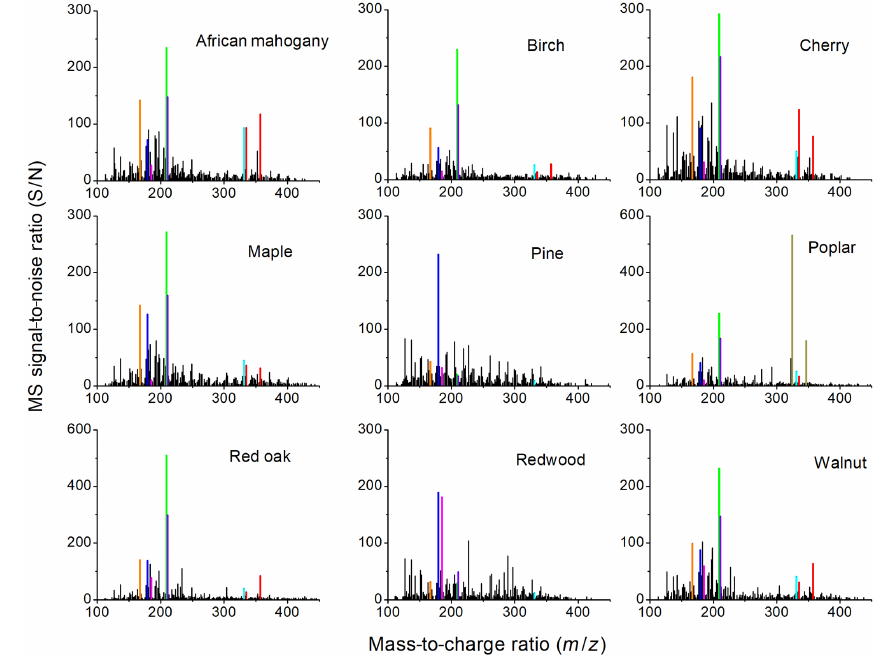
Figure 3. High-resolution mass spectra of WSA extracts in the study, taken at 100µgmL − 1 concentration. The color key for highlighted peaks with proposed assignments for the major species at each peak is as follows: orange – C 9 H 10 O 3 , acetovanillone, or homovanillin (protonated); blue – C 10 H 10 O 3 , coniferyl aldehyde (protonated); magenta – C 6 H 10 O 5 , levoglucosan, mannosan, or galactosan (sodiated); green – C 11 H 12 O 4 , sinapaldehyde (protonated); cyan – C 18 H 18 O 6 , G-vanillin dimer (protonated); red – C 18 H 22 O 6 , various S-G dimers (protonated and sodiated); dark yellow – C 20 H 21 NO 3 , unknown alkaloid (protonated and